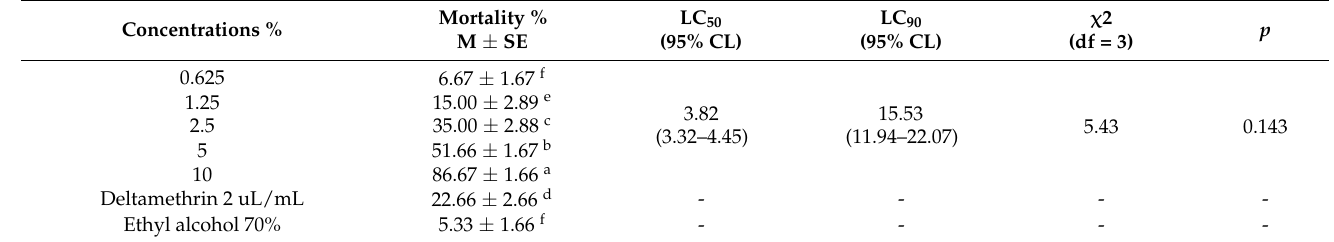
Table 4. Larvicidal activity and lethal concentrations (LC 50 , LC 90) of Lavandula stoechas , against larvae of R. annulatus